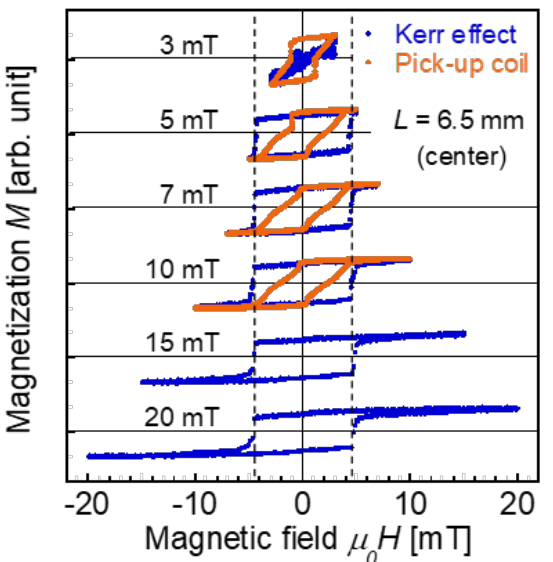
Figure 3. Magnetization curves of the Wiegand wire obtained from the MOKE and voltage induced in the pick-up coil. The measurement position is L = 6.5 mm, which is the center of the wire. An alternating magnetic field of | H ap | = 3 to 20 mT/ μ 0 is applied.